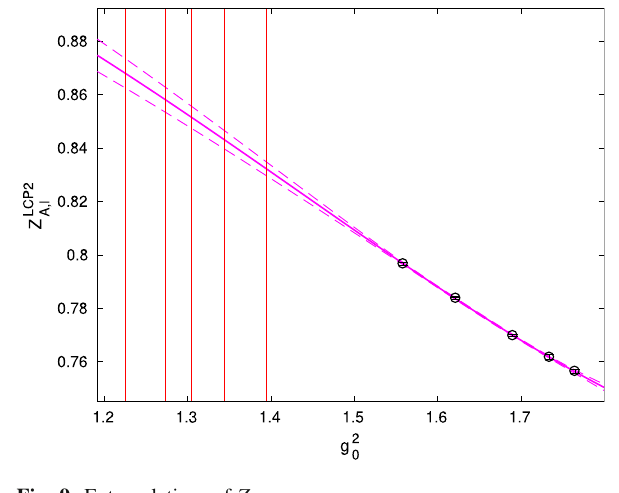
Fig. 9 Extrapolations of Z A